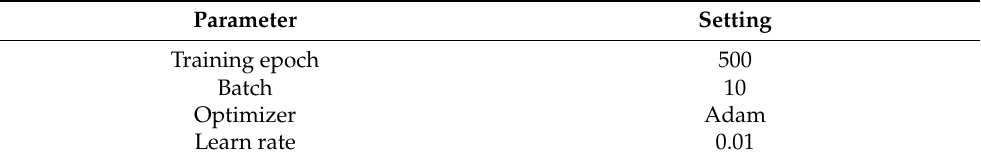
Table 3. Hyper-parameters for the emotion state representation model